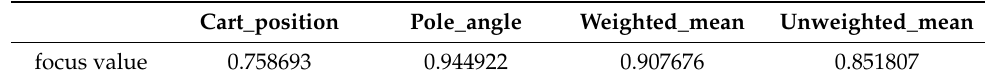
Table A5. Focus value of the cartpole agent.